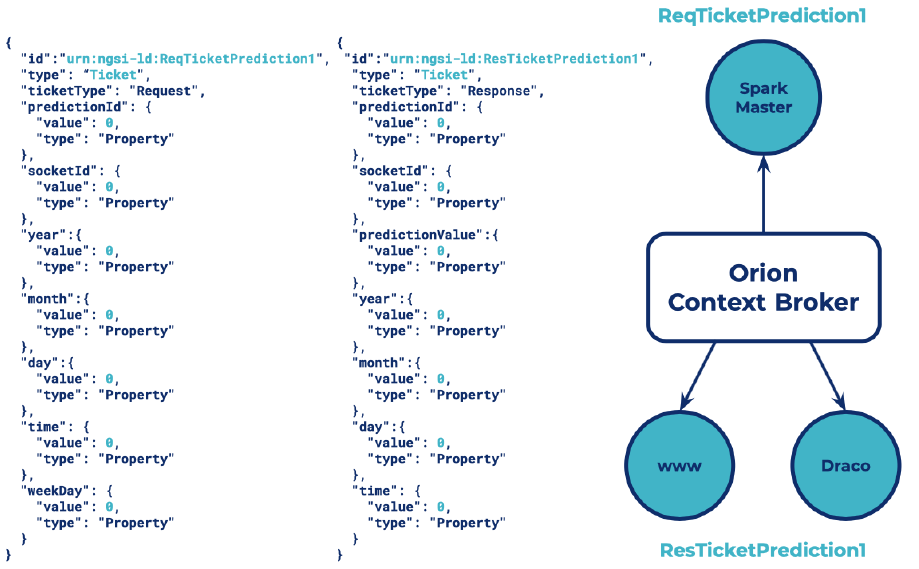
Figure 11. Schema of entities and service